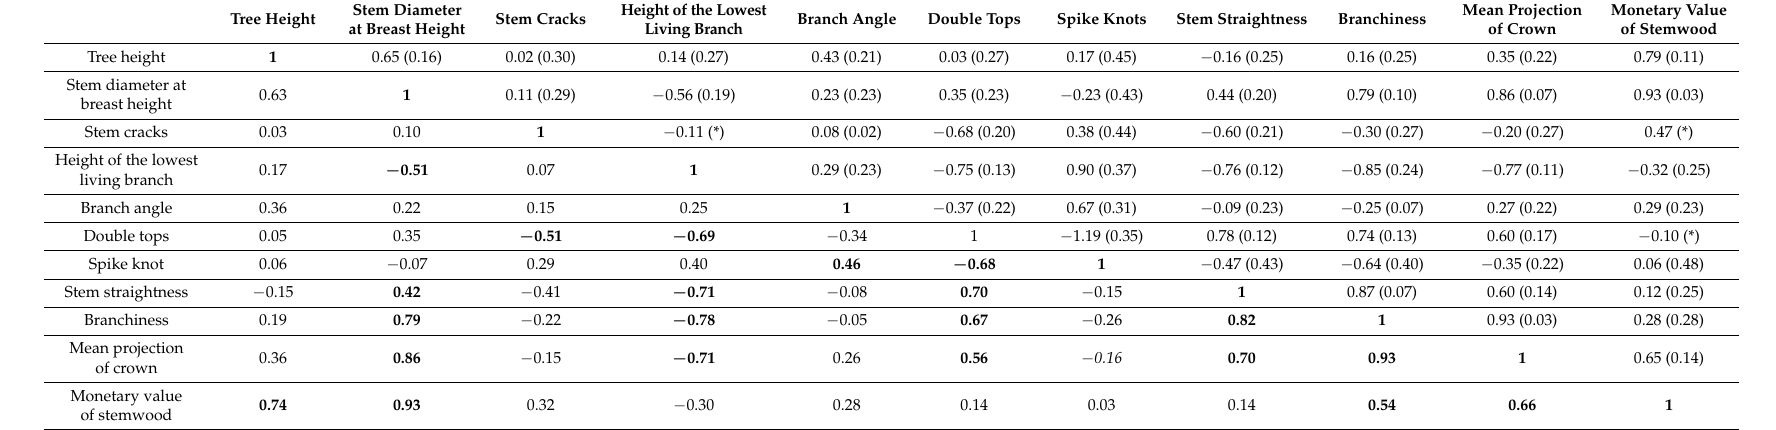
Table 3. Genotypic correlations (standard errors by delta method in brackets) in the upper diagonal part and phenotypic clone mean Pearson correlations (significant correlations with p ≤ 0.05 in bold) in the lower diagonal part (*—calculation stopped due to infinite